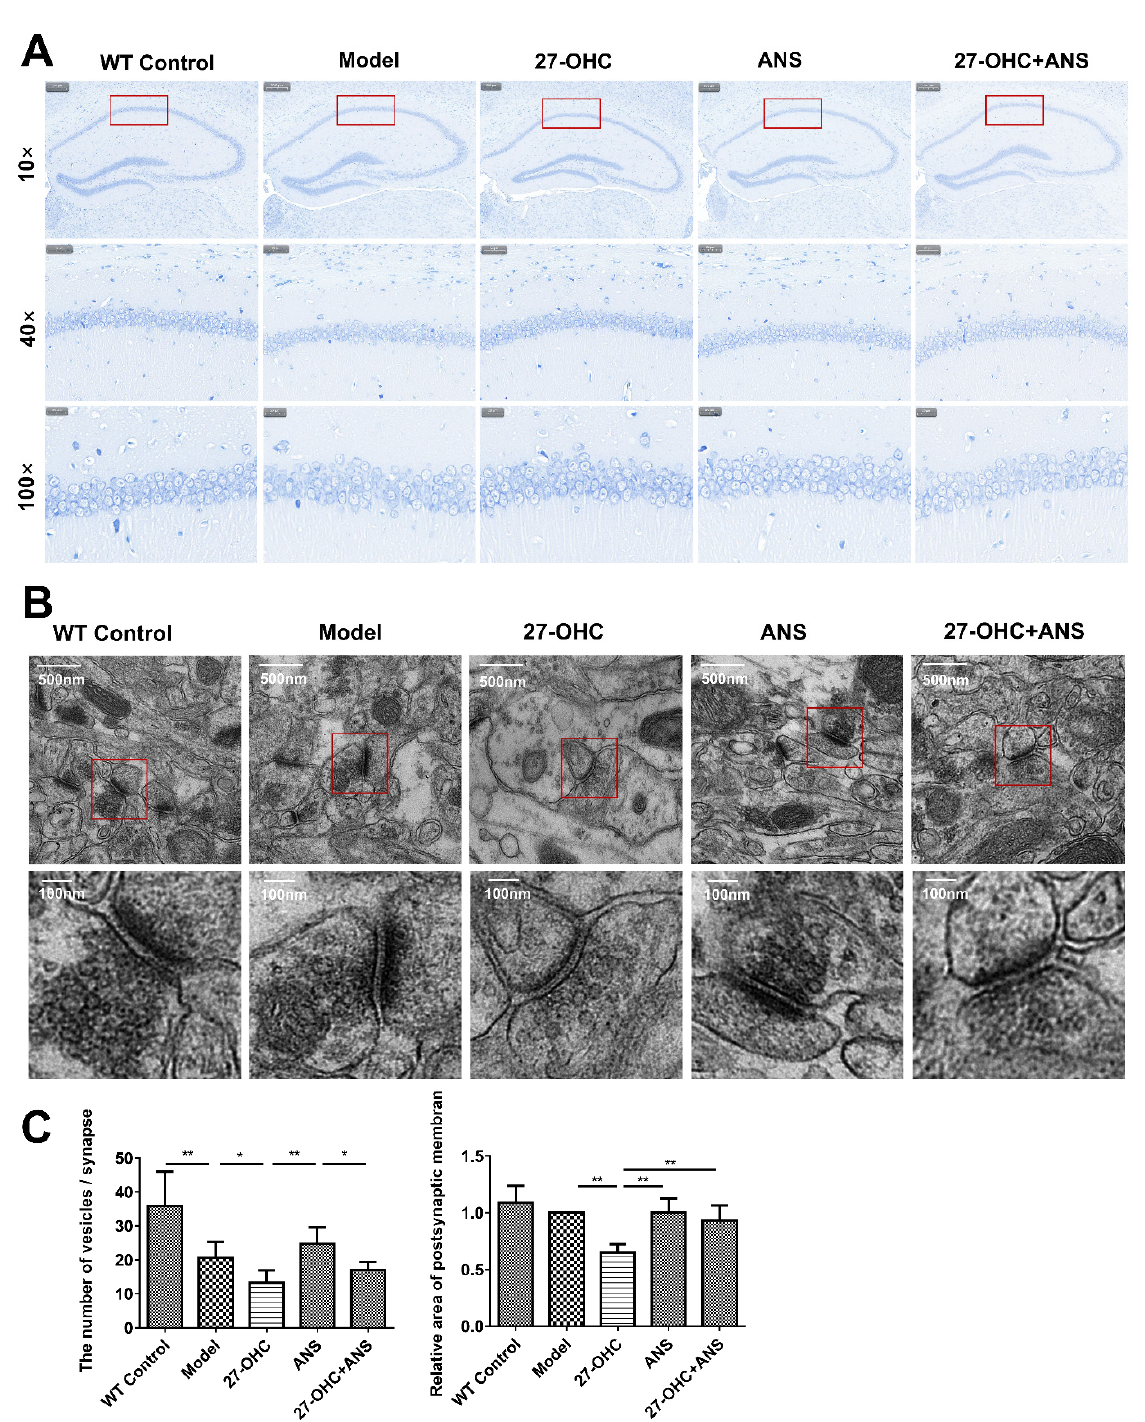
Figure 3. Brain tissue structure and nerve synapses in mice. ( A ) Nissl staining of brain after invention in each group under different magnifications:10× (scale bar = 200 μ m), 40× (scale bar = 50 μ m), and 100× (scale bar = 20 μ m). ( B ) Observation and statistical analysis of the synaptic microstructure of hippocampus CA1 area under a transmission electron microscope. Low magnitude (scale bar = 500 nm); high magnitude (scale bar = 100 nm). ( C ) Statistical analysis of synaptic vesicle and postsynaptic membrane area. All data are shown as mean ± SD. * p < 0.05; ** p < 0.01 (one-way ANOVA). Synapse-related proteins, such as growth-associated protein 43 (GAP43), postsynaptic density protein 95 (PSD95), activity-regulated cytoskeleton-associated protein (Arc),